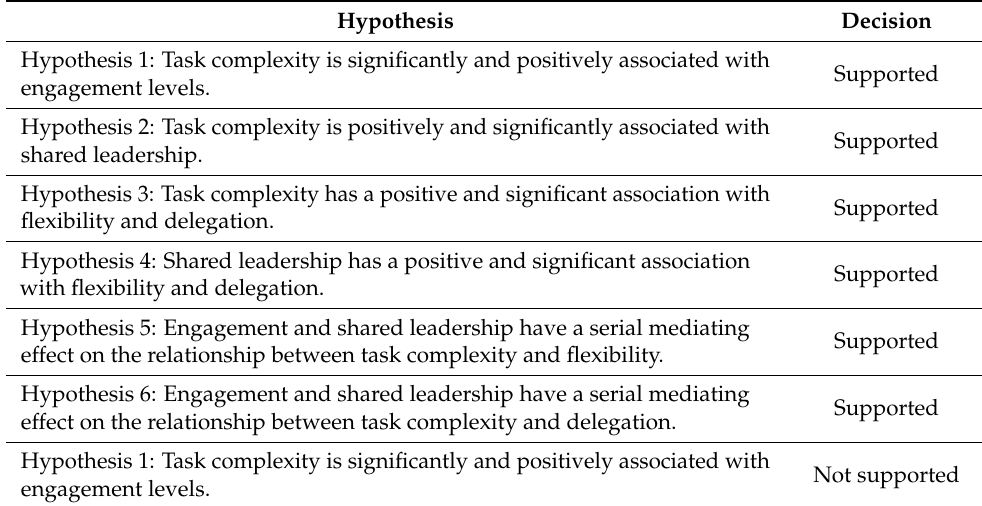
Table 9. Synthesis of the hypotheses results. Hypothesis